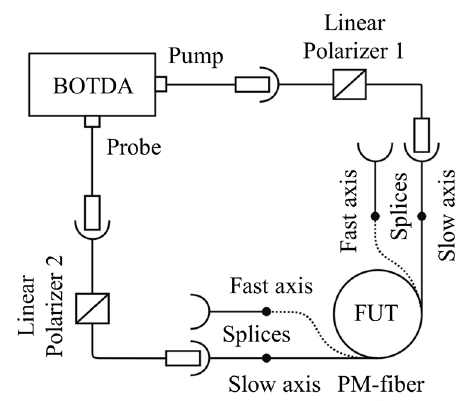
Figure 5. An experimental set-up for obtaining the distribution of birefringence in a PM optical fiber.